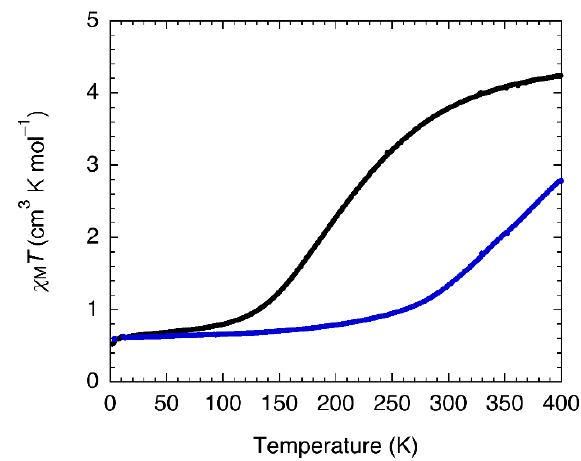
Figure 4. Plots of the χ M T versus temperature over the temperature range 2–400 K in an applied dc field of 0.5 T at scan rate of 2 K min –1 for 1 (black) and 2 (blue).